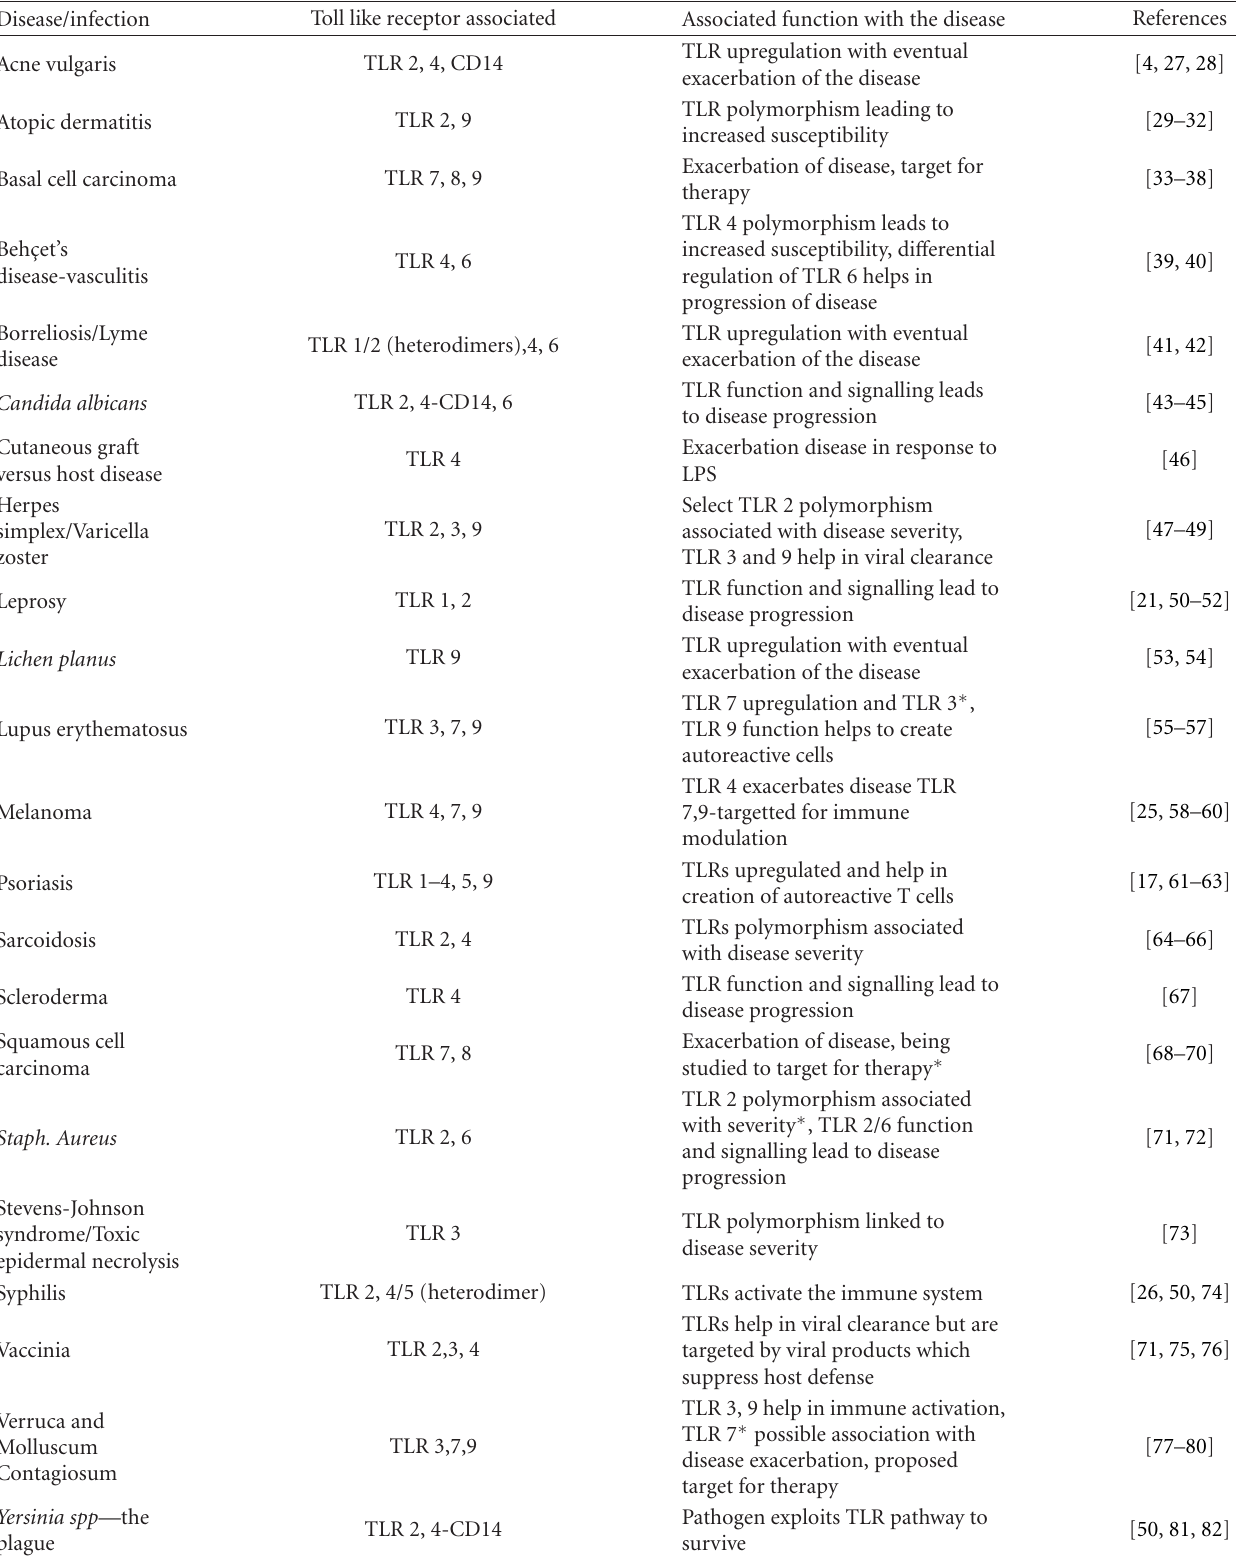
Table 1: Toll like Receptors in dermatologic